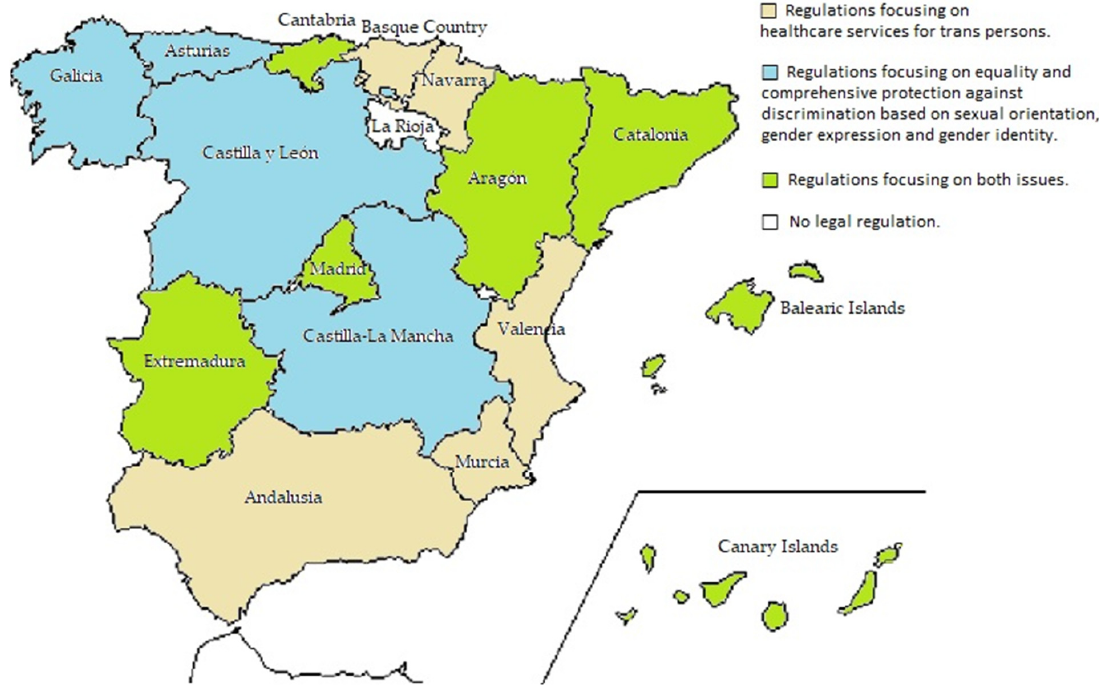
Figure 1. Regional laws passed regulating healthcare and the rights of LGTBI people. Spain (2011– 2021).